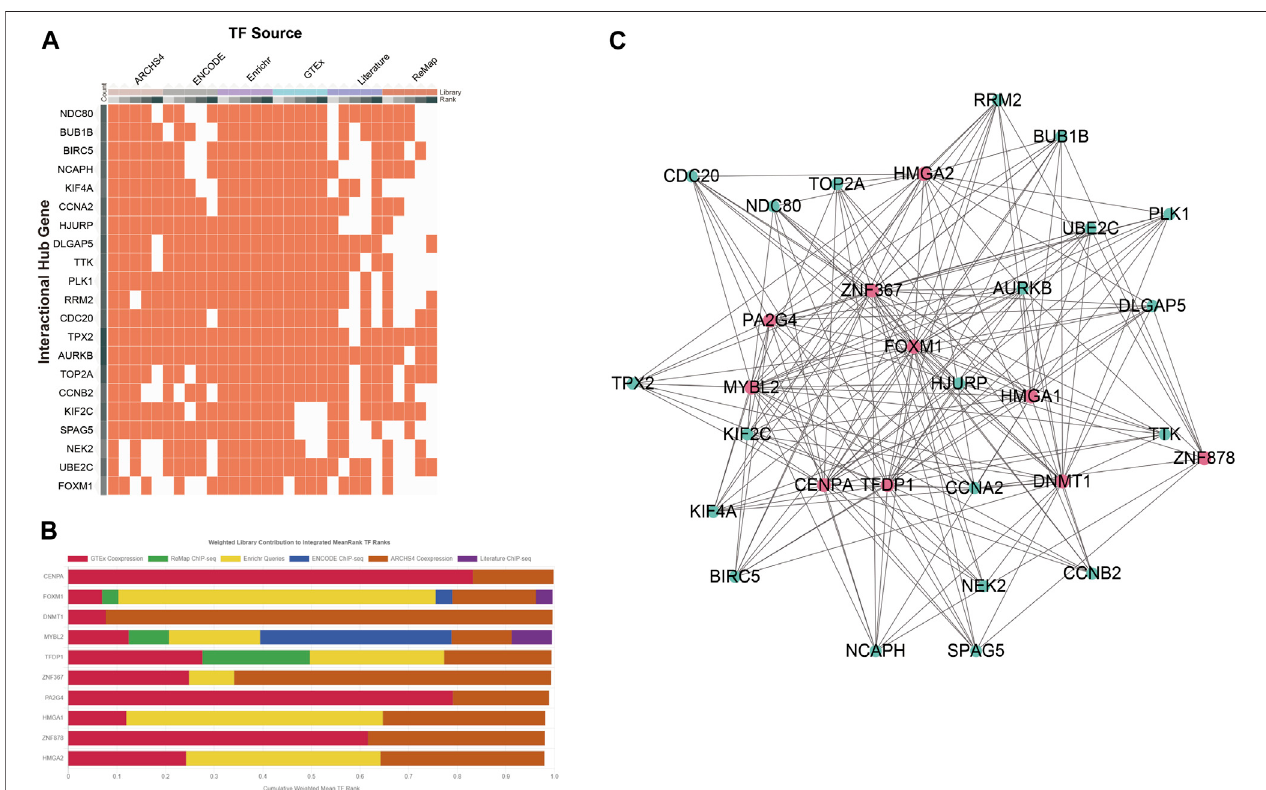
FIGURE 7 | Determination of regulatory signatures (TFs). (A) Data source of TFs of the COVID-19/NSCLC interactional hub gene. (B) Top 10 TFs identi fi ed by the ChEA3 database. (C) TFs – interactional hub genes interaction network. Note: red nodes represent TFs, green nodes represent genes, and edges represent interaction relationships in panel (C)